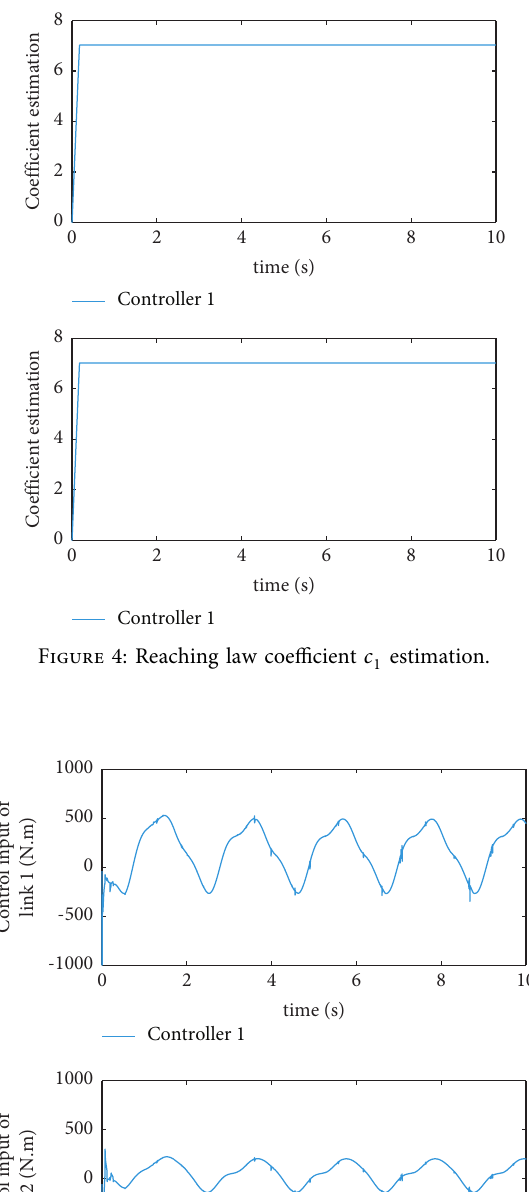
Figure 5: Control